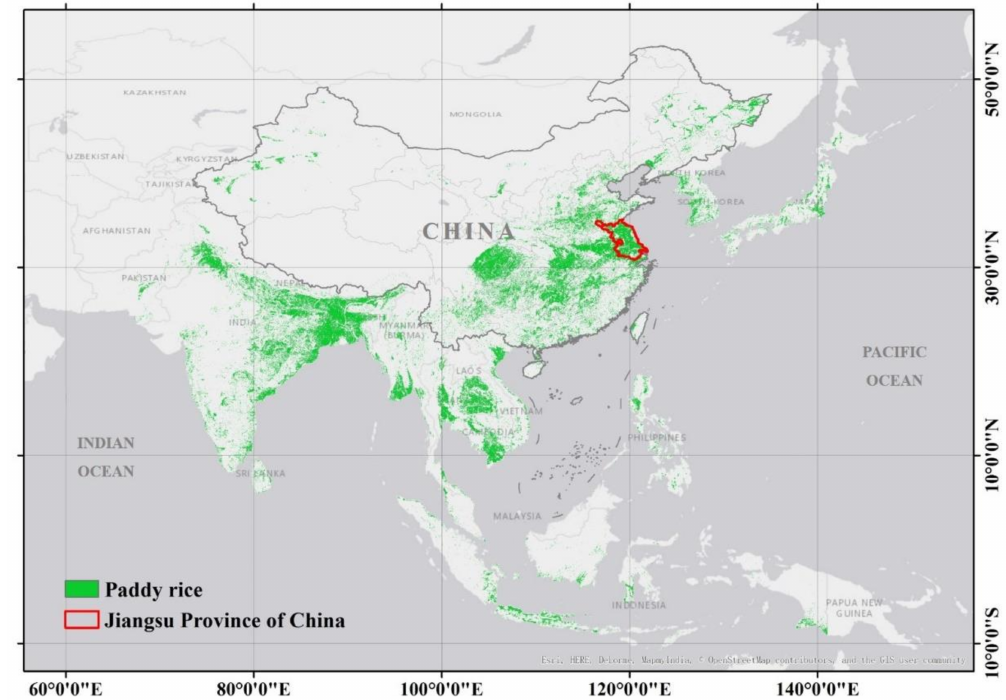
Figure 1. Paddy rice distribution in monsoon Asia with the boundary of Jiangsu Province overlaid.